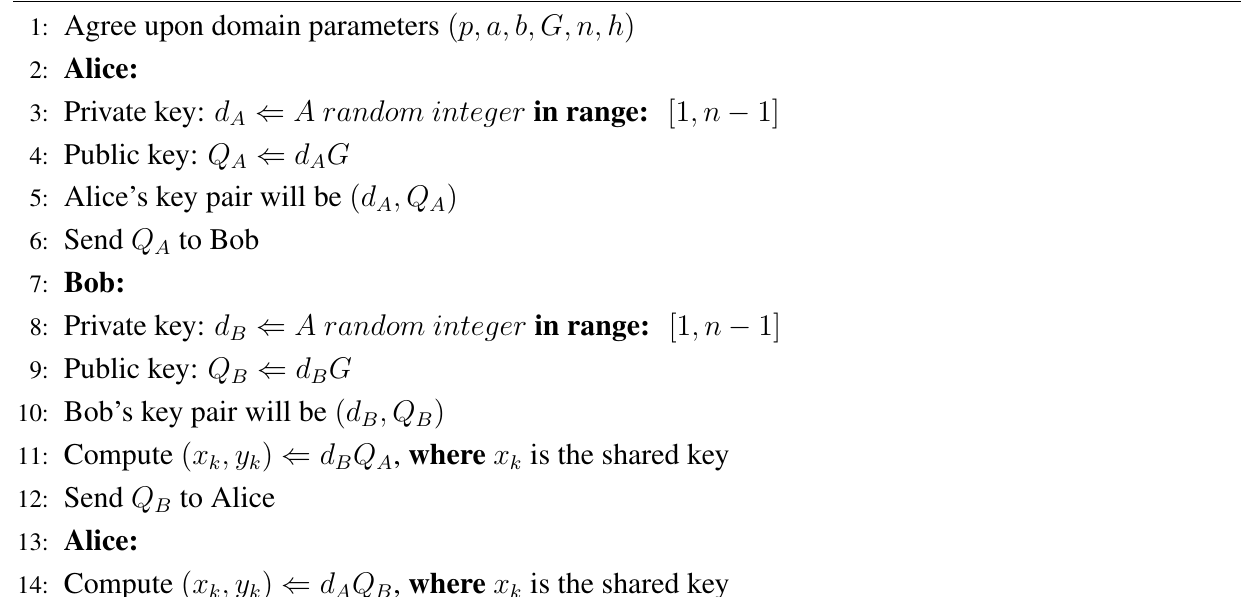
Algorithm 1 Elliptic curve Diffie-Hellman (ECDH) key agreement.